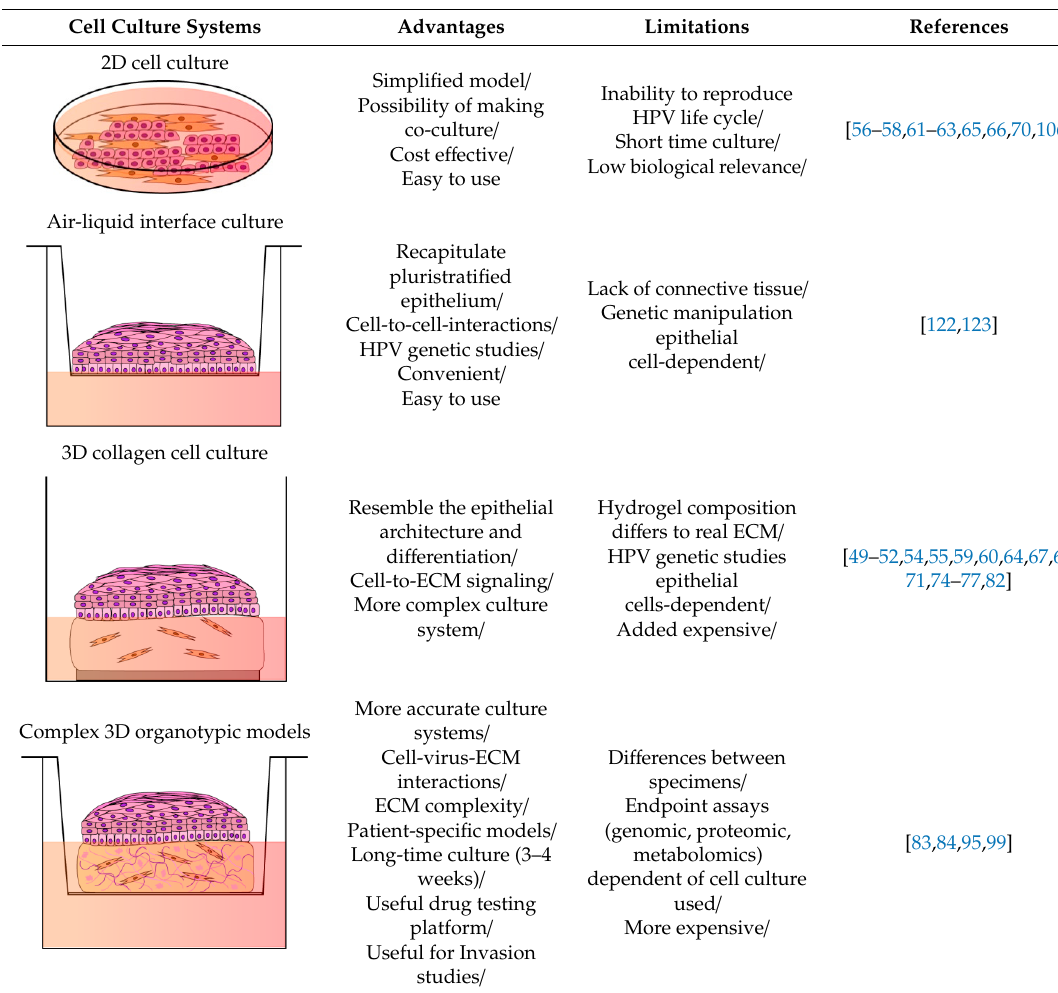
Table 2. Summary of organotypic cervical models pointing out their advantages and